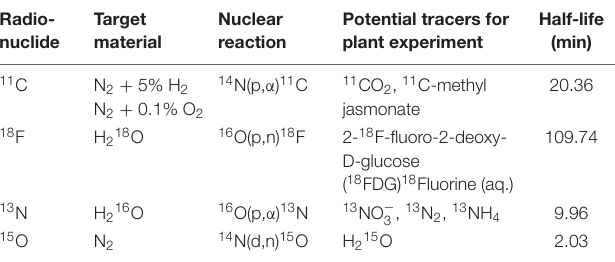
TABLE 1 | Production information and potential tracers of positron emitting tracers used in plant science along with their half-life. Radio- Target nuclide